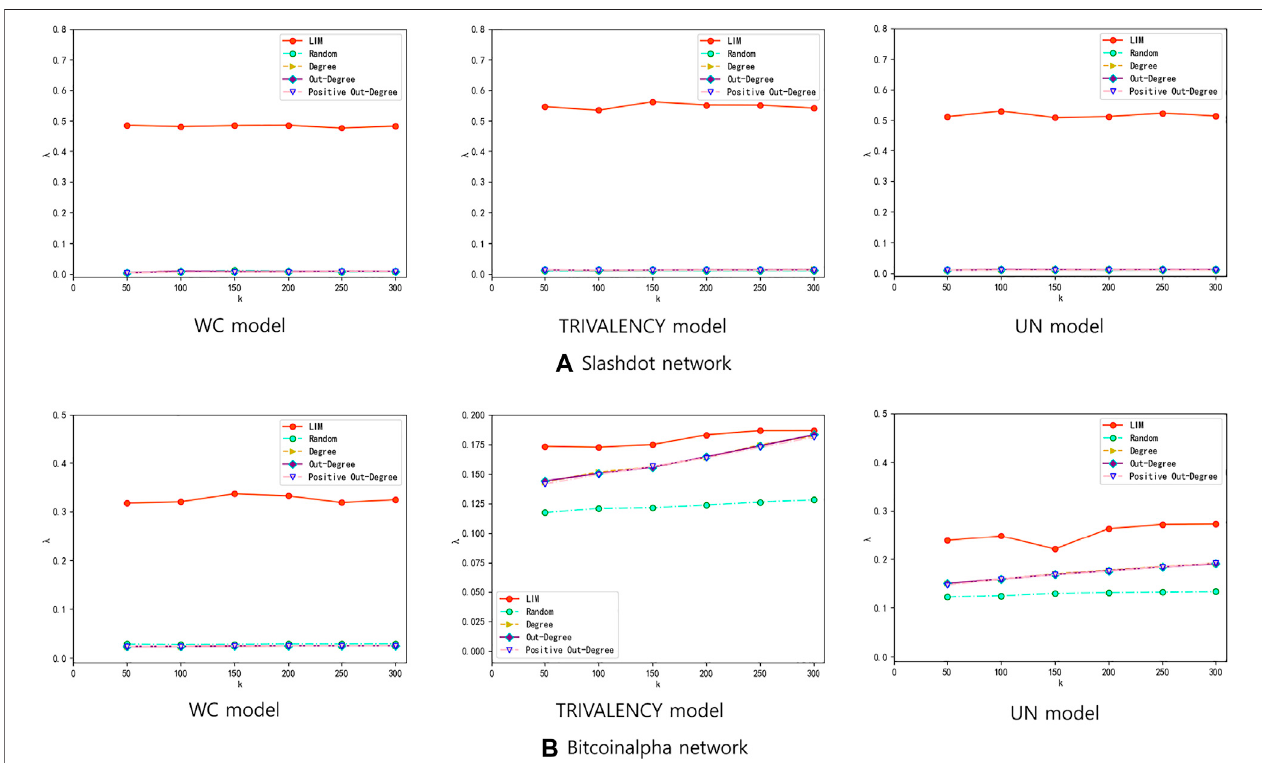
FIGURE 5 | Result Comparisons between LIM method and some degree-based centrality methods when applying on (A) Slashdot network (B) Bitcoinalpha network. The experiments are conducted on (A) Slashdot network (B) Bitcoinalpha network. Three diffusion probability methods are considered, i.e. WC model, TRIVALENCY model, and UN model. For UN model, the probability value we set is 0.03. In each experiment, parameter k means that k seeds are selected to activate other nodes, and λ means the proportion of positively activated target nodes among all activated nodes. The targets we set are a center node with small coreness and nodes within two steps from it. (A) On the Slashdot network, node 2,921 is the center node. (B) On the Bitcoinalpha network, the center node we set in targets is node 7,062. Ranking methods include Degree (yellow triangles), Out-Degree (purple diamonds), Positive Out-Degree (pink triangles), Random (green circles), and LIM (red circle) methods. The results in each fi gure are obtained by averaging over 2,000 independent realizations.